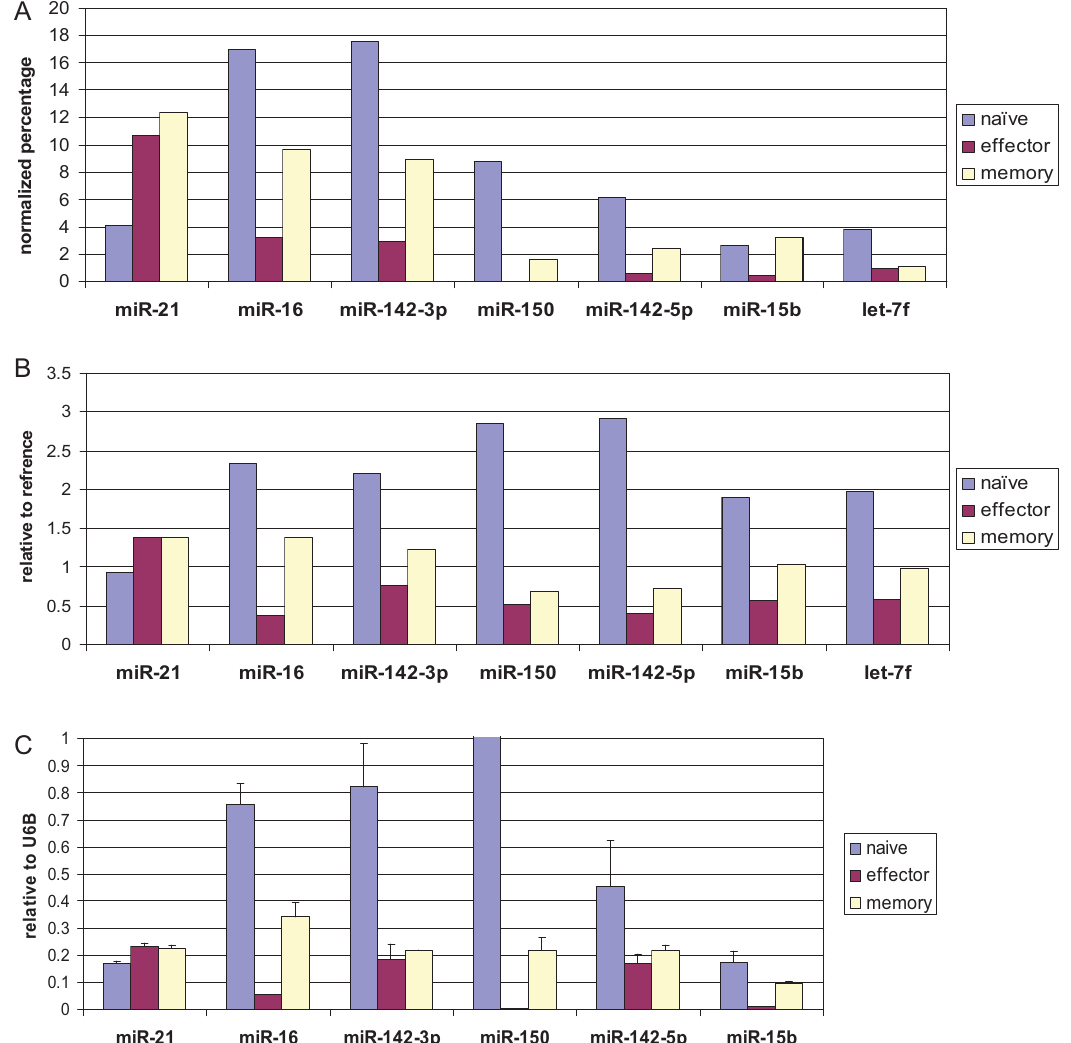
Figure 3. Comparison of miRNA expression profile in the T cell subsets by 3 different methods. A) Expression profile by direct cloning. The cloning frequency was normalized to the total hybridization signal in the miRNA microarray. B) Expression profile by microarray hybridization. Ratios of sample/reference hybridization signal is shown. C) Expression profile by real time PCR. Expression level was normalized to that of small non-coding RNA U6B. Mean of triplicate experiments 6 SD is shown. Similar results were also obtained in 2 additional independent